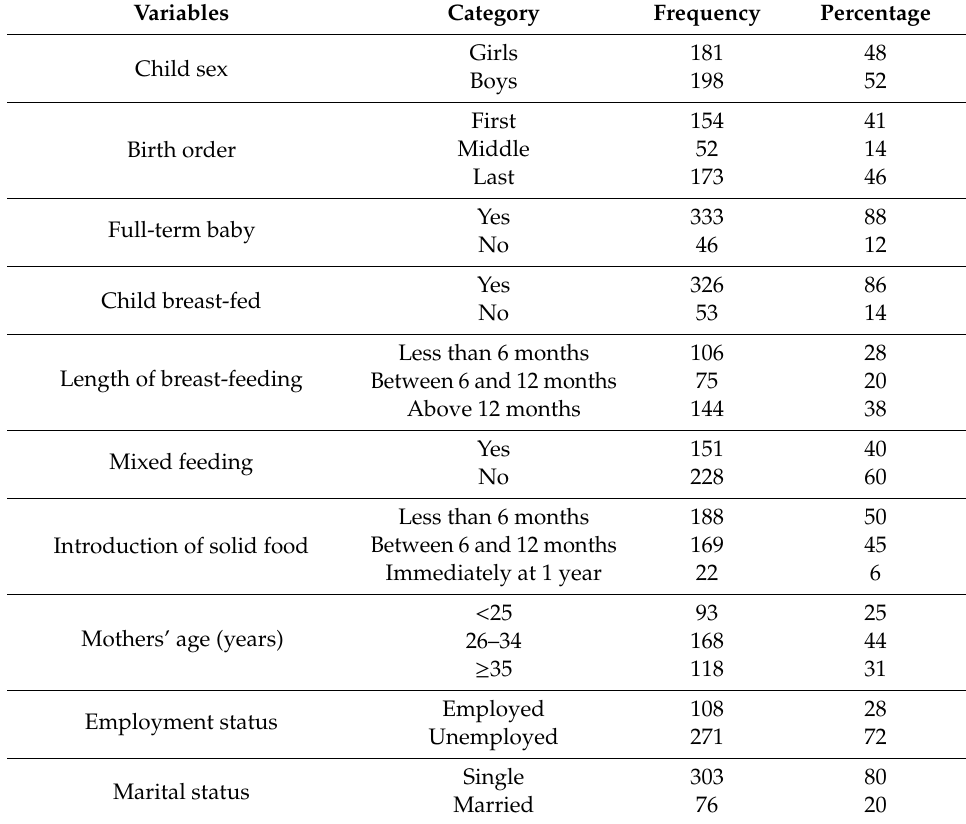
Table 1. Descriptive characteristics of children and their mothers ( n =